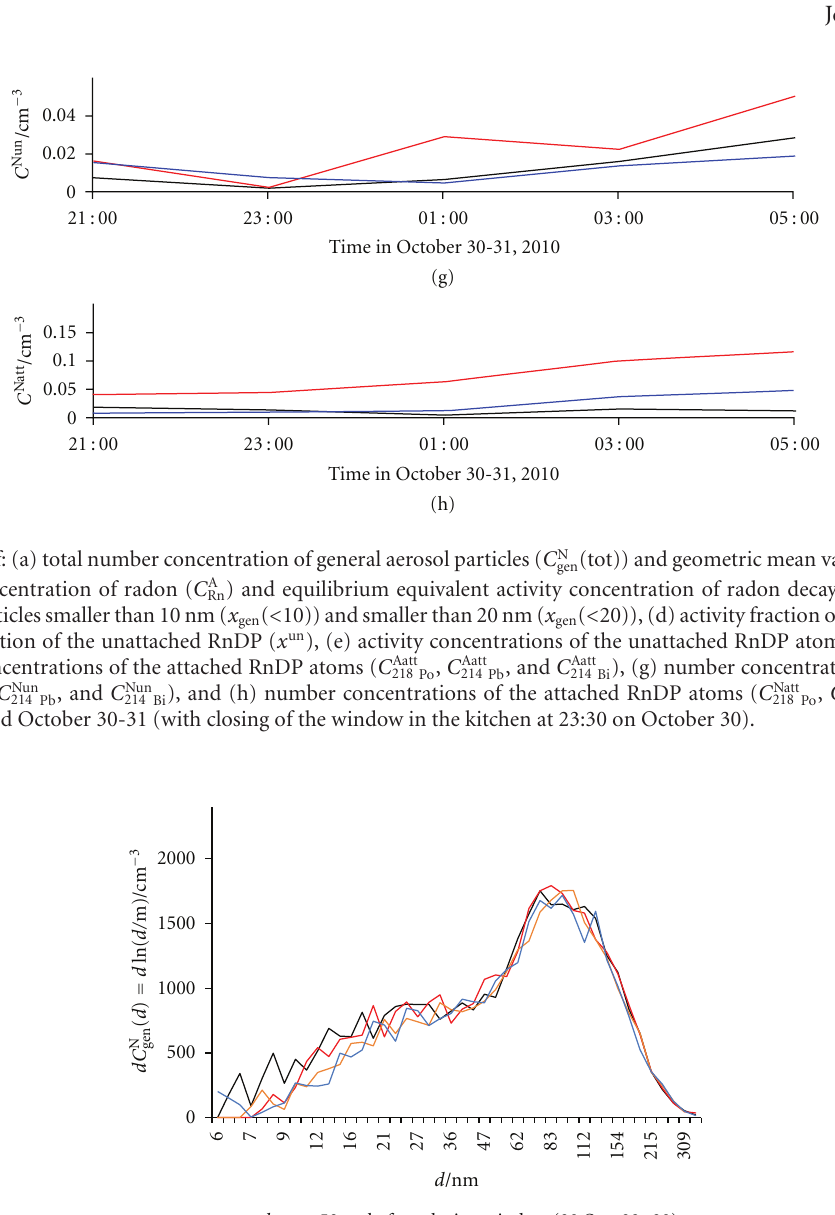
( d ) = dln( d/ m)) of general aerosol particles in indoor air before and after closing of the window gen